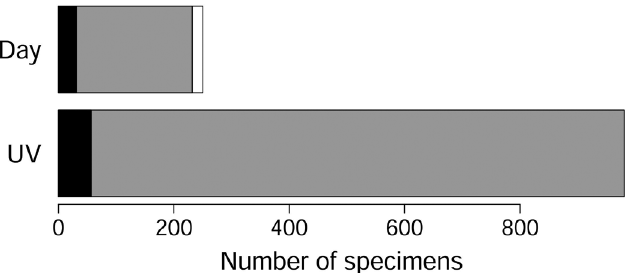
Fig. 5. Number of mantid specimens collected with the two main sampling methods: day capture (Day) and trapping with UV lights at night (UV); black chart = females; grey chart = males; white chart = nymphs.